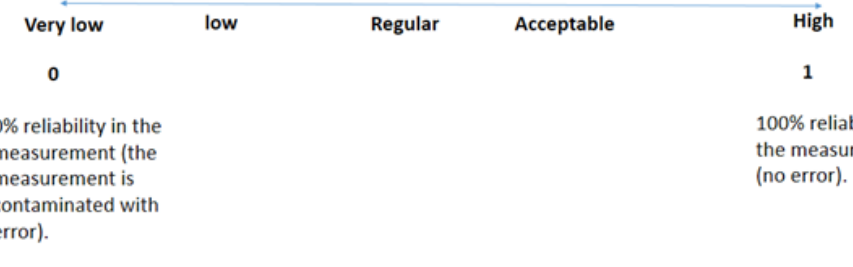
Figure 1. Validation of weights in Cronbach’s